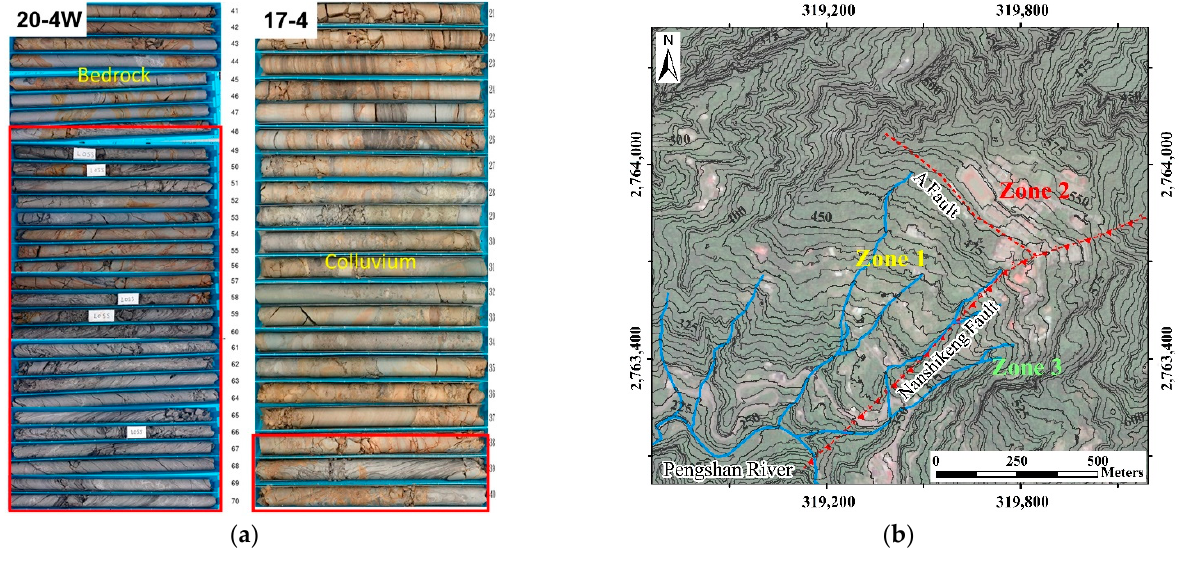
Figure 5. Geological uniform zones of the study area: ( a ) Fracture and shear zones within the red rectangles of the boreholes 20-4W and 17-4, showing a steep bedding dip angle composed of rock fragments as well as clay-rich material. Borehole 20-4W reveals that the damage zone and shear gouge may be found at depths of 56.5–59.6 m, 60.6–62.6 m, and 64.7–66.2 m, with partially crushed gouge having a ~3 cm thick bending shear plane; and ( b ) stratigraphy of the Mushan Formation, separated into the three zones by the Nanshihkeng Fault and A Fault.